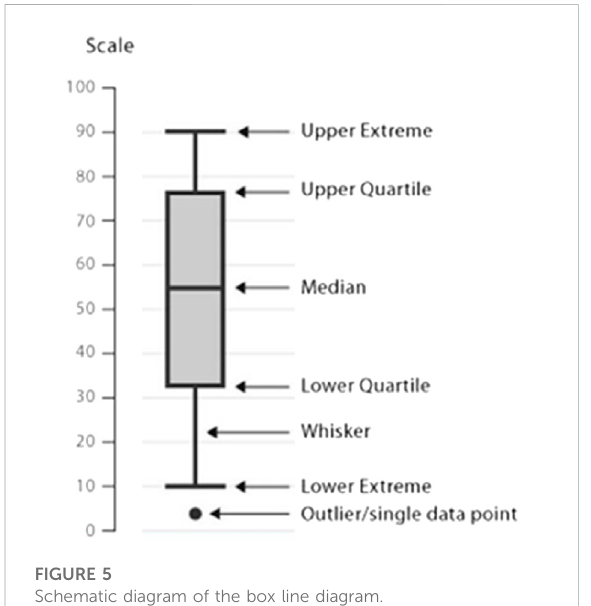
FIGURE 5 Schematic diagram of the box line diagram.